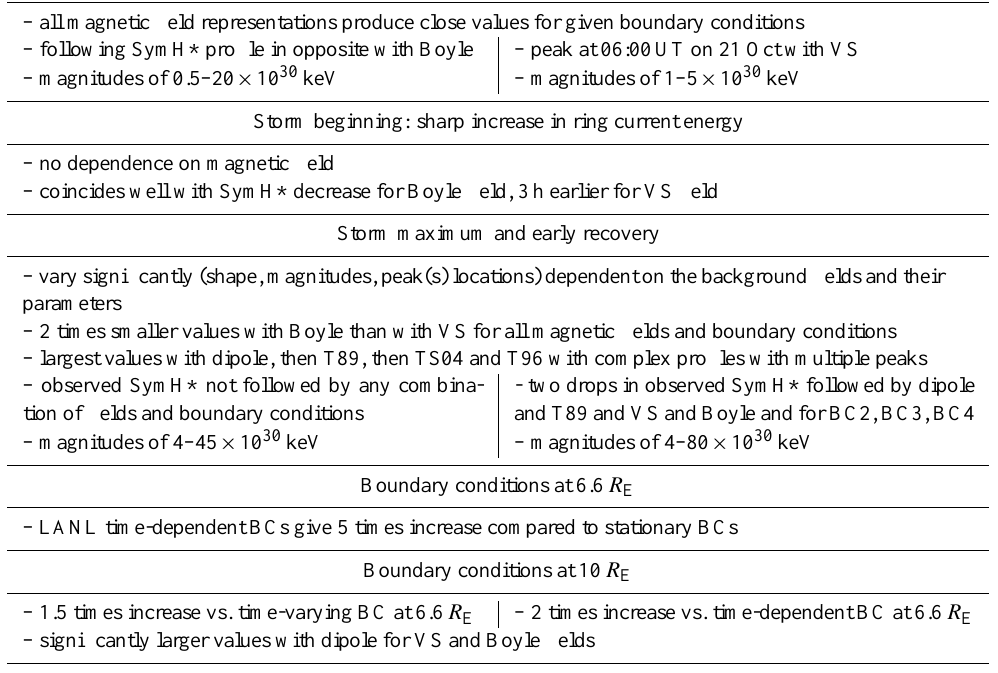
Table 1. Model-dependent storm-time ring current: ring current energy profiles. Moderate storm Intense storm Before storm: filling of initially empty